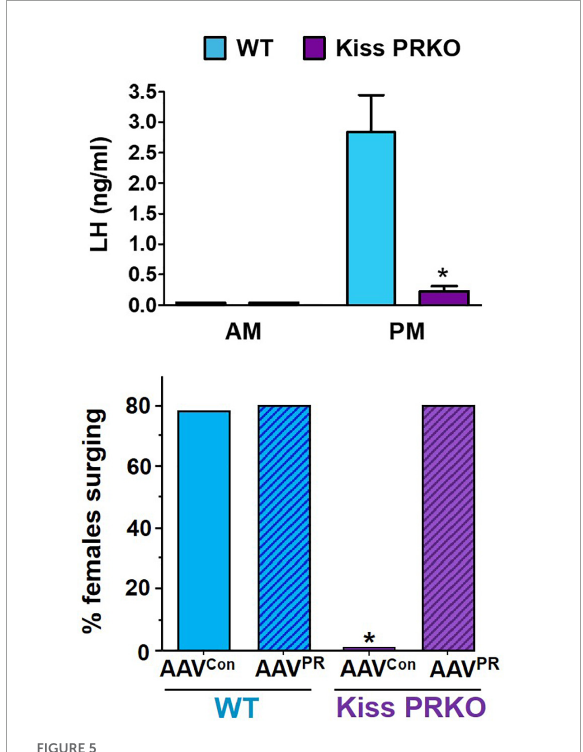
FIGURE5 (Top) Importance of progesterone in the LH surge process as indicated by reduced PM LH surge generation in OVX + E 2 female mice lacking PR selectively in kisspeptin cells (“Kiss PRKO”; Kiss Cre + /PR flox ). Adapted from Stephens et al. (2015); Bottom. Selective re-expression of PR in just RP3V KISS neurons using RP3V targeted AAVs rescues the LH surge occurrence in OVX + E 2 Kiss PRKOs. *, Significantly different that WT controls. Adapted from Mohr et al. (2021a) AAV con , viral delivery of